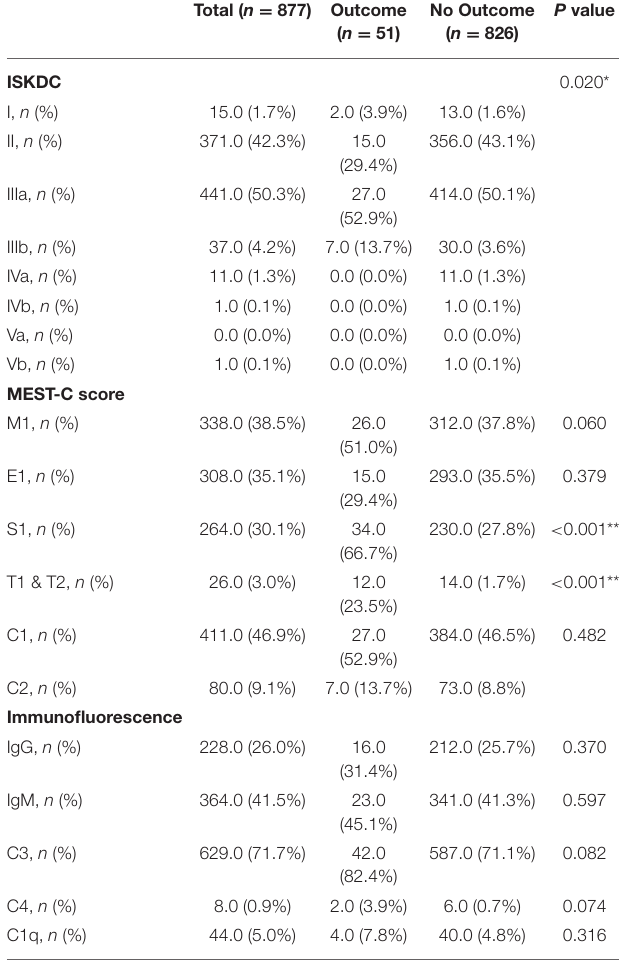
TABLE 2 | Pathological features of the children with